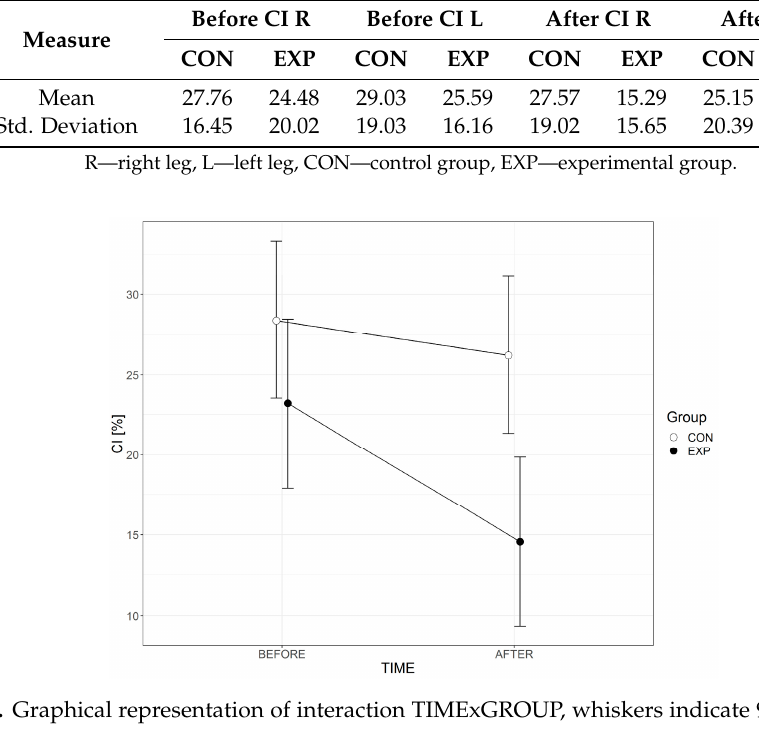
Figure 2. Graphical representation of interaction TIMExGROUP, whiskers indicate 95% confidence intervals as the combination of right and left legs.